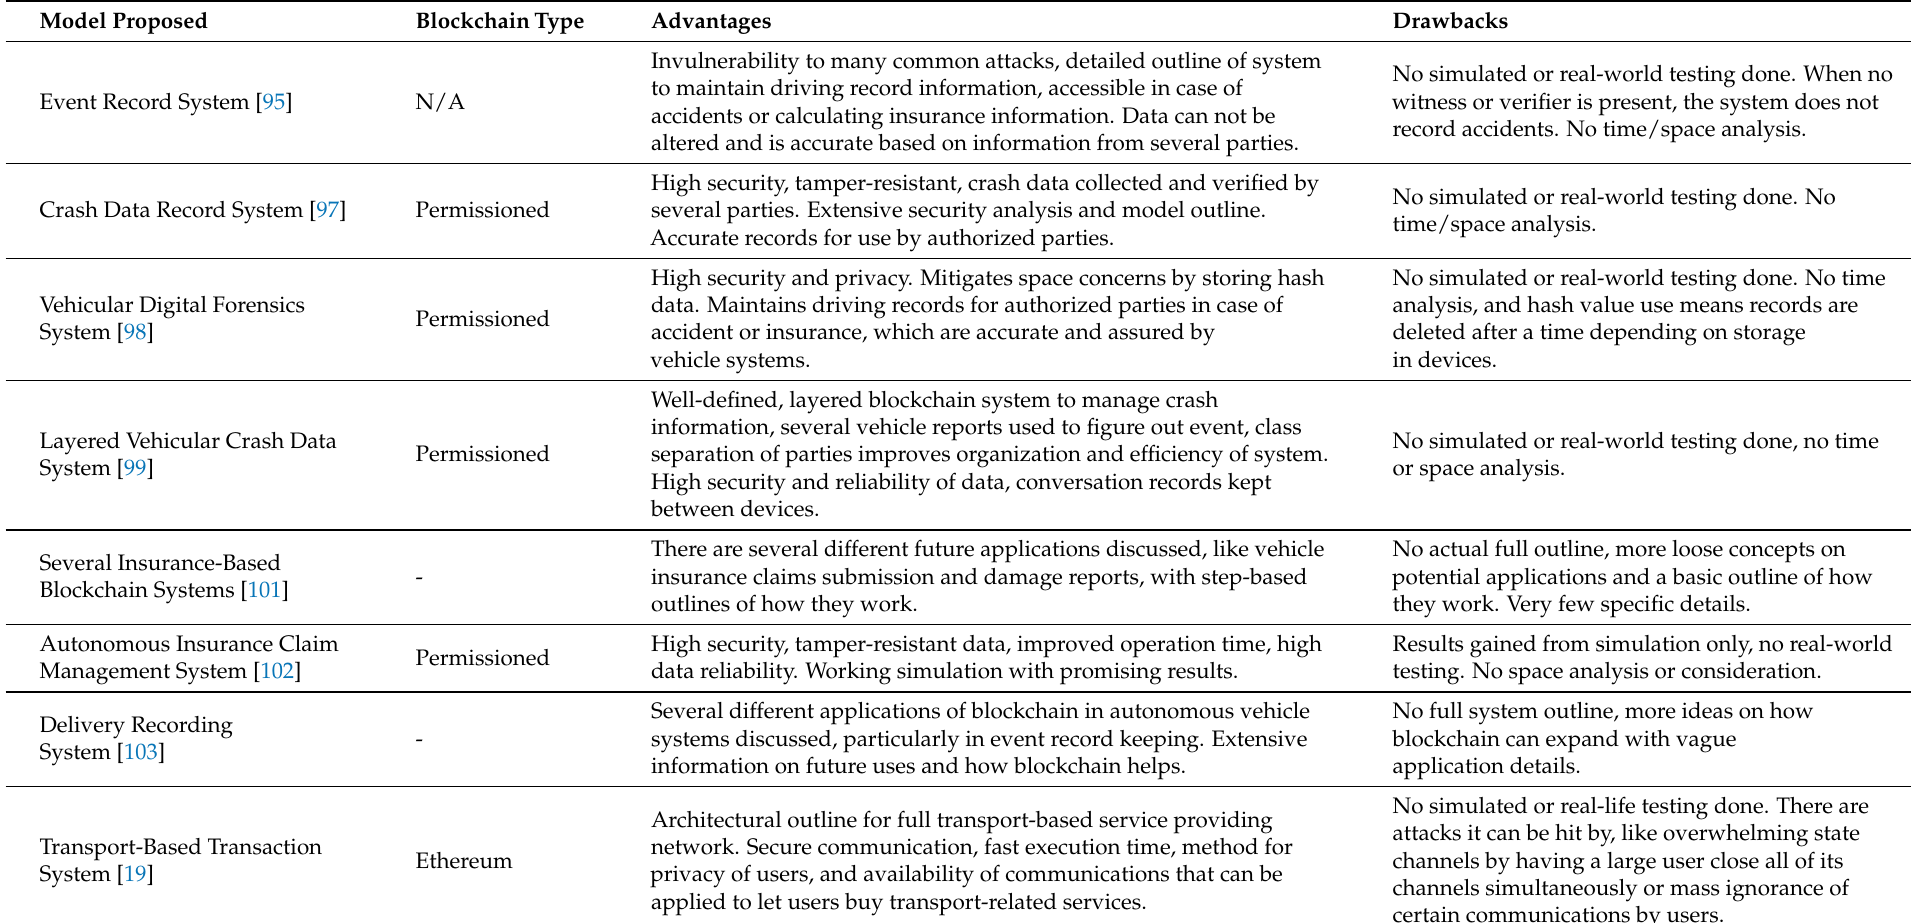
Table 5. Comparison of selected record-keeping and maintenance methods in terms of advantages, drawbacks, and type of blockchain used. Model